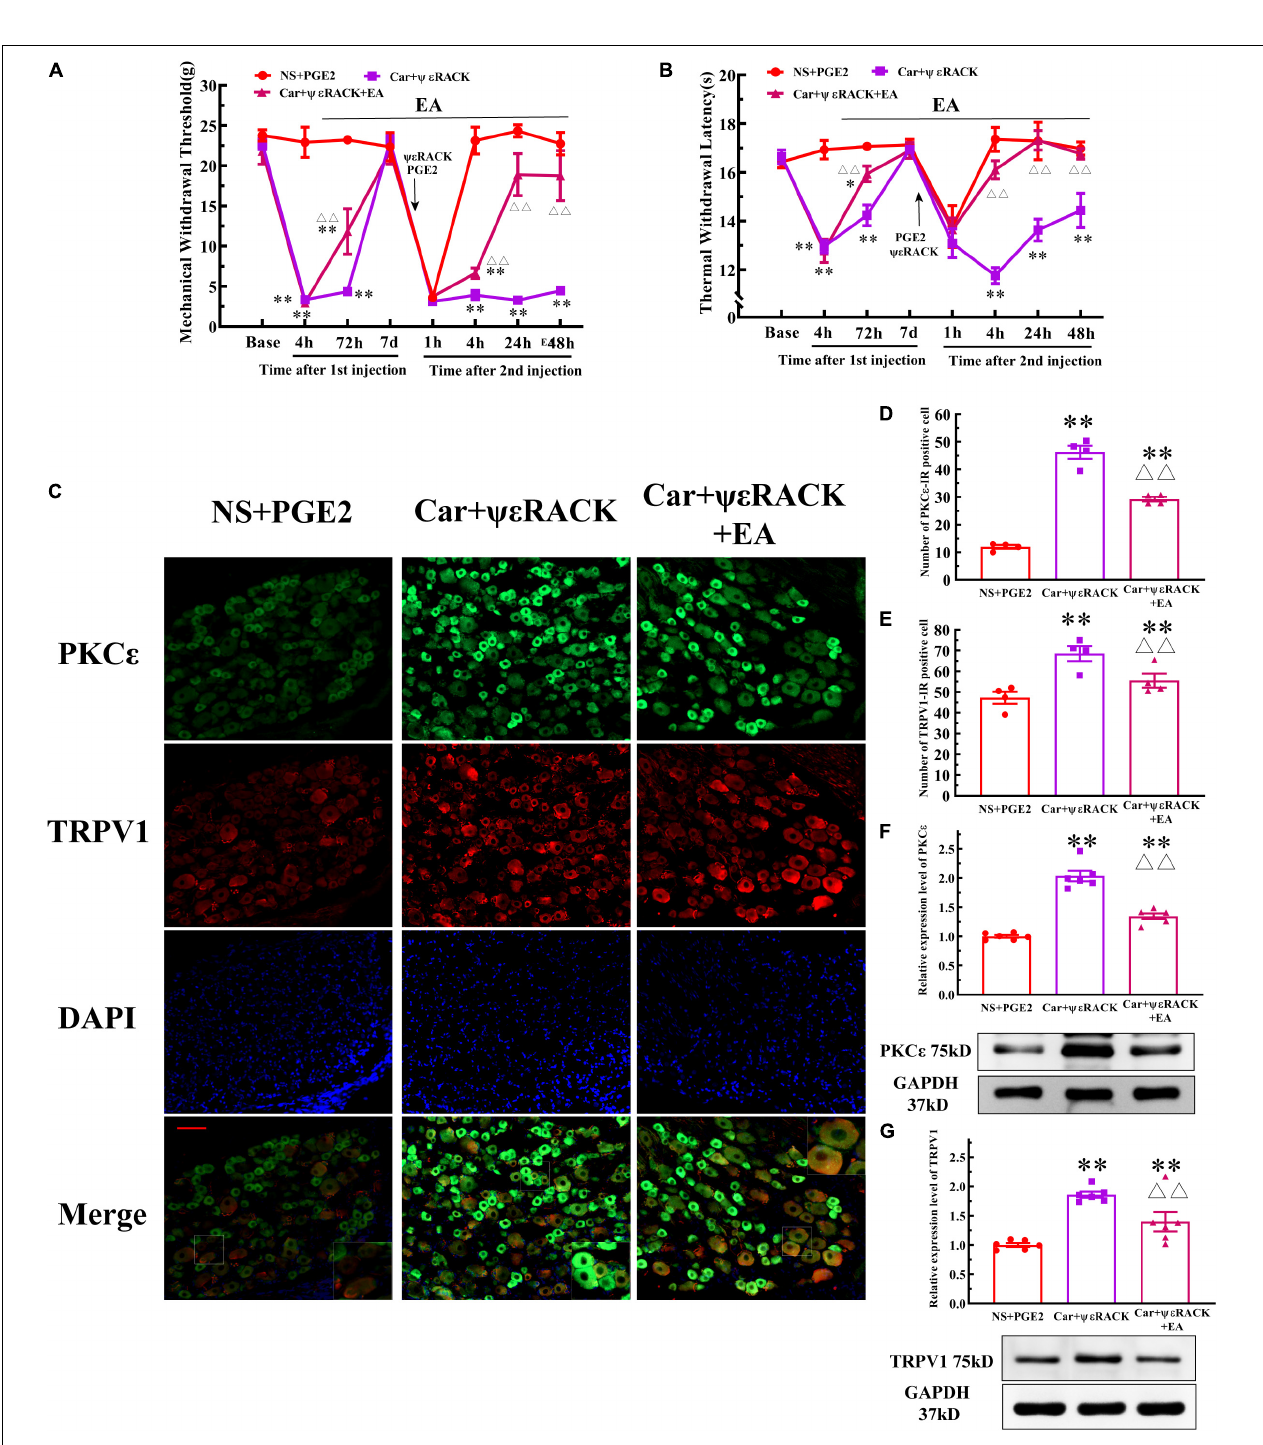
FIGURE 7 | Electroacupuncture (EA) regulates the transition from acute to chronic pain induced by ψε RACK injection. Mechanical (A) and thermal (B) responses of Car/ ψε RACK-injected animals to EA administration. n = 6. (C) PKC ε and TRPV1 staining in the peripheral nervous system 48 h after ψε RACK injection. Scale bar, 100 µ m. The quantification of the PKC ε –IR positive (D) and TRPV1–IR positive (E) neurons. The quantification of the Western blot results and a representative Western blot showing PKC ε (F) and TRPV1 (G) protein isolated from the DRG 48 h after ψε RACK injection. *, **Compared with the NS+PGE2 group, P < 0.05, P < 0.01; (cid:52)(cid:52) compared with the ψε RACK group, P < 0.01.